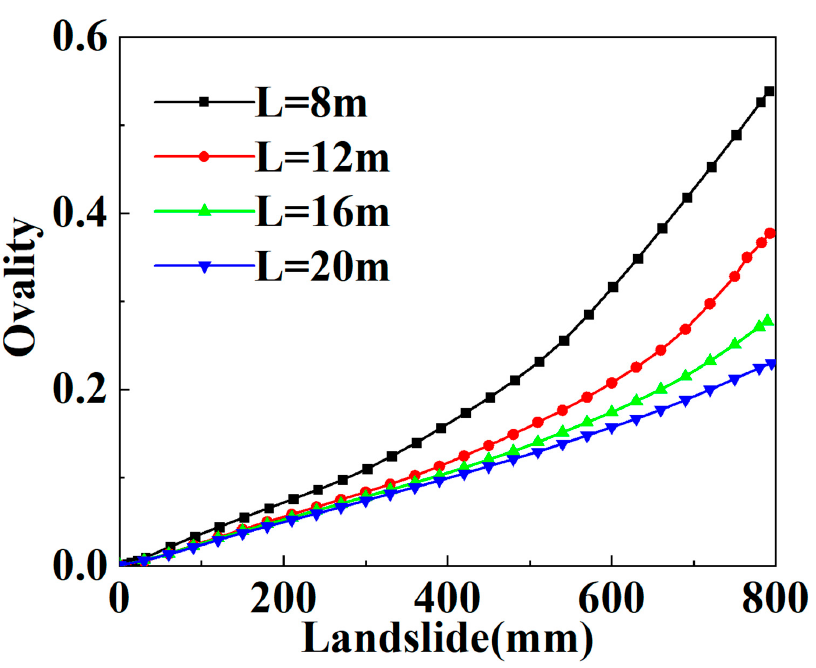
Figure 19. Influence of landslide on δ of the SWW-RTP in soil with different landslide area widths.